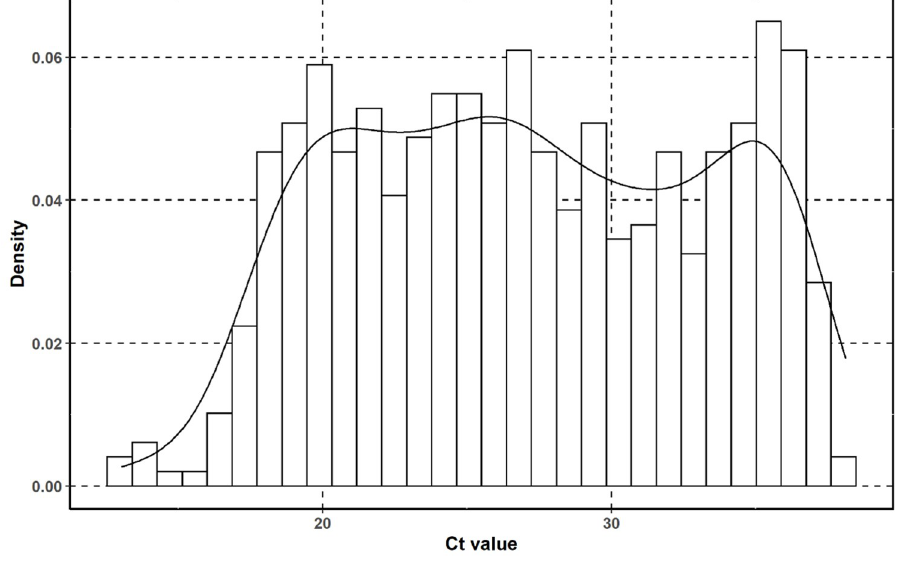
Fig 1. Ct value distribution of the RT-qPCR samples in the whole study group on a histogram with kernel density curve.